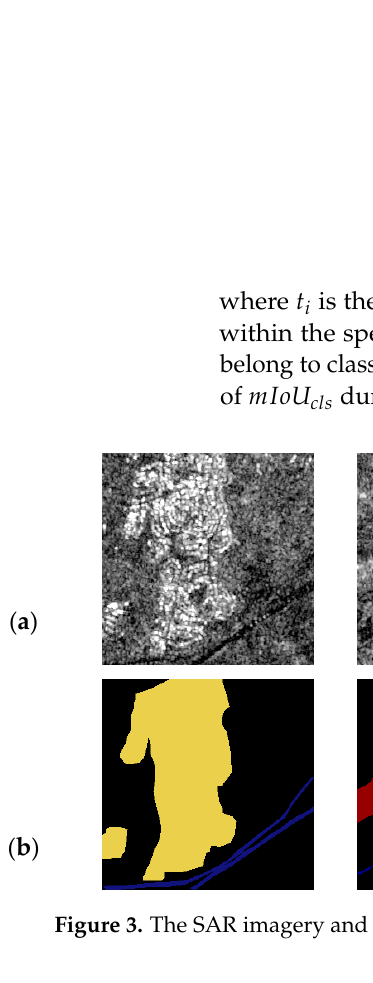
Figure 4. ( a ) The convergence of the proposed loss function; ( b ) the change in